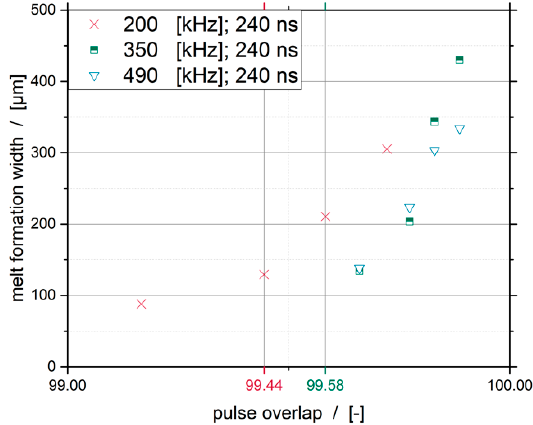
Figure 11. Influence of the pulse overlap on the melt formation width for a pulse width of 240 ns.